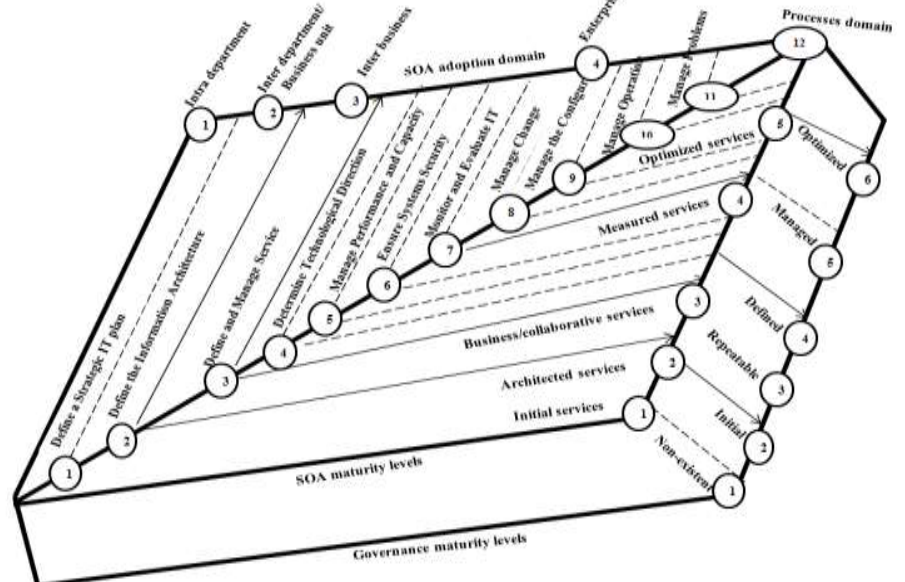
Figure 3. Conceptual framework to evaluate SOA